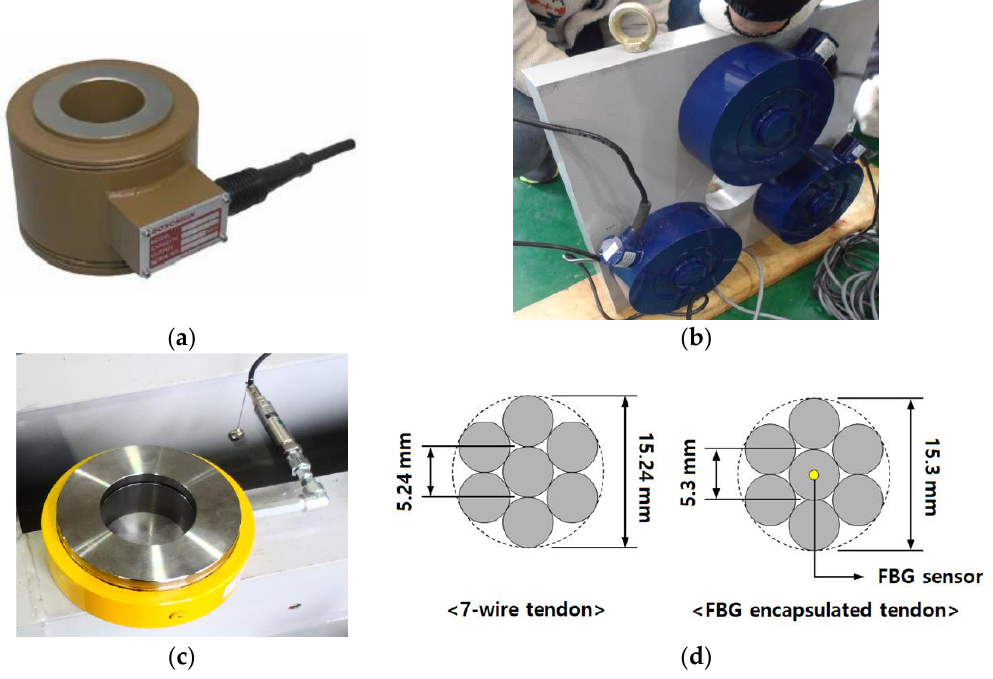
Figure 1. Sensors tested in this study. ( a ) Center-hole load cell; ( b ) Tri-sensor loading plate; ( c ) Hydraulic load cell; ( d ) Fiber Bragg Grating (FBG) sensor encapsulated seven-wire steel tendon.